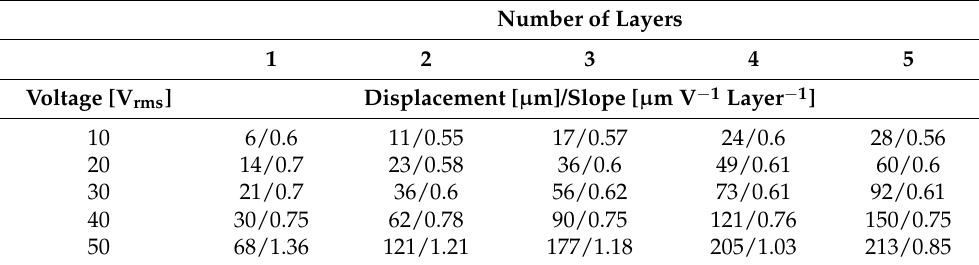
Table 1. The out of plane displacement for different driving voltages and the number of active layers at resonance frequency. Additionally, the incremental slope is given.